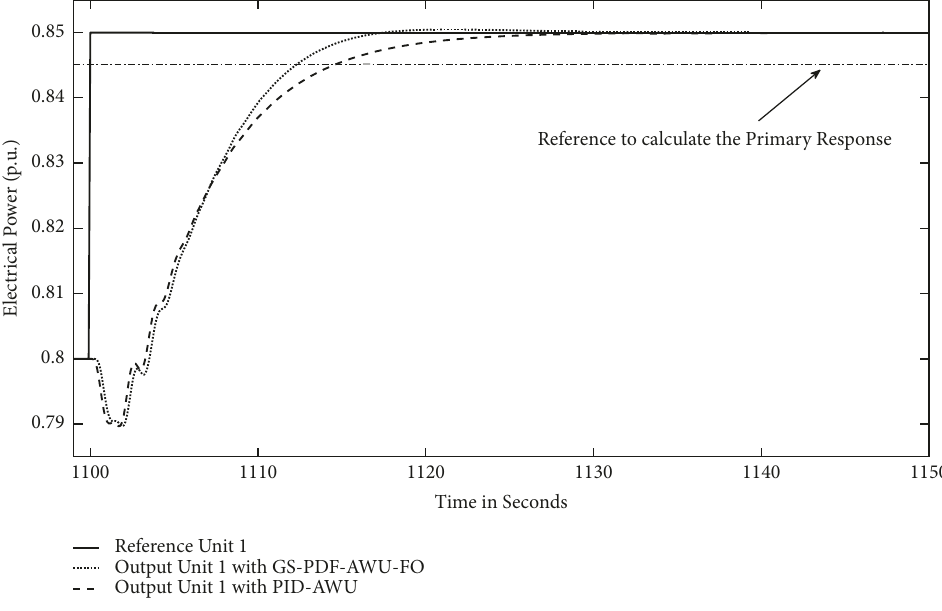
Figure 14: PID and GS-PDF-FO step responses, both with antiwindup, six operational units, and